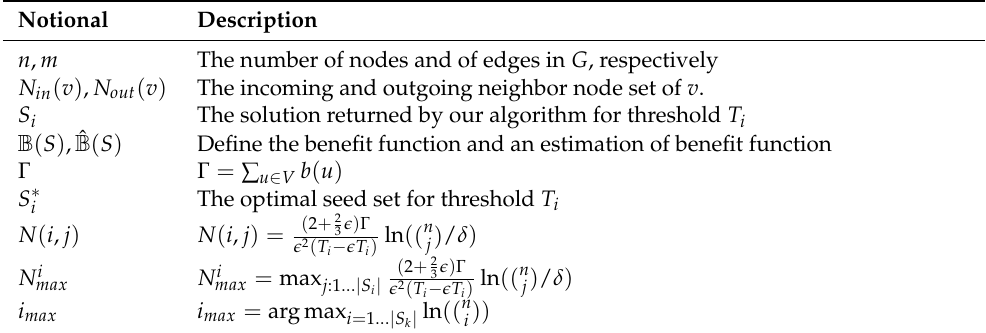
Table 1. Table of